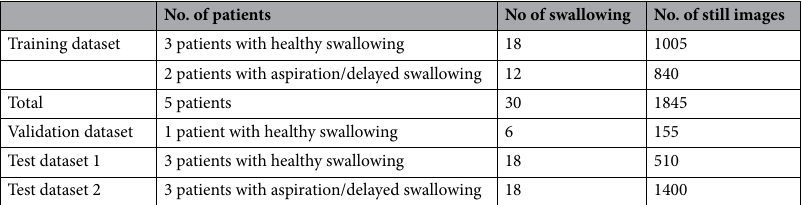
Table 2. Allocation to training, validation, and test